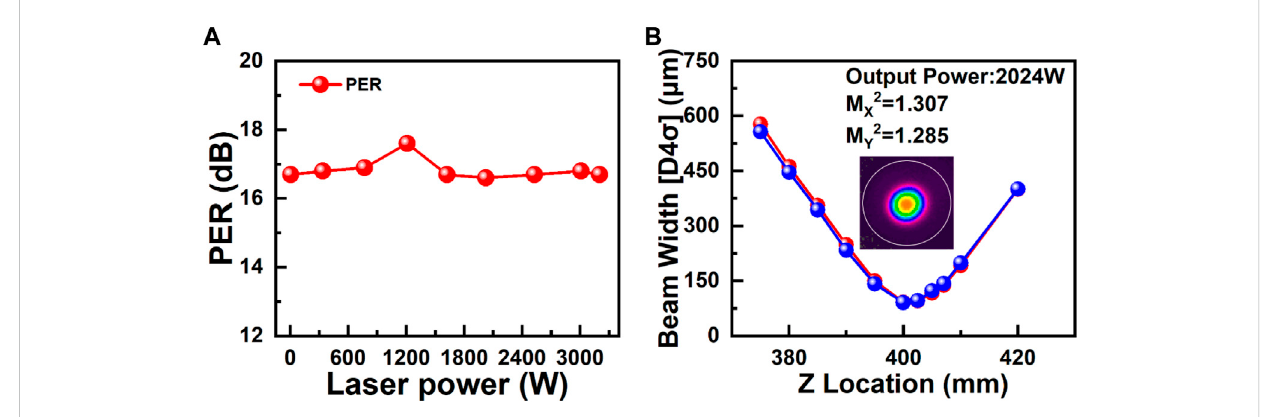
FIGURE 8 (A) PERversuslaserpowerofaMOPAsystem. (B) DiffractionlimitedbeamqualityoftheimprovedMOPAsystemat2024WaftersuppressingtheSBS and mitigation of